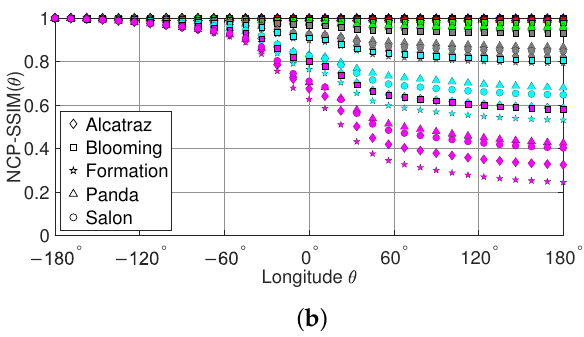
Figure 20. Visual quality of viewing direction based LSB data hiding in the longitude: ( a ) SSIM( θ ), ( b ) NCP-SSIM( θ ).